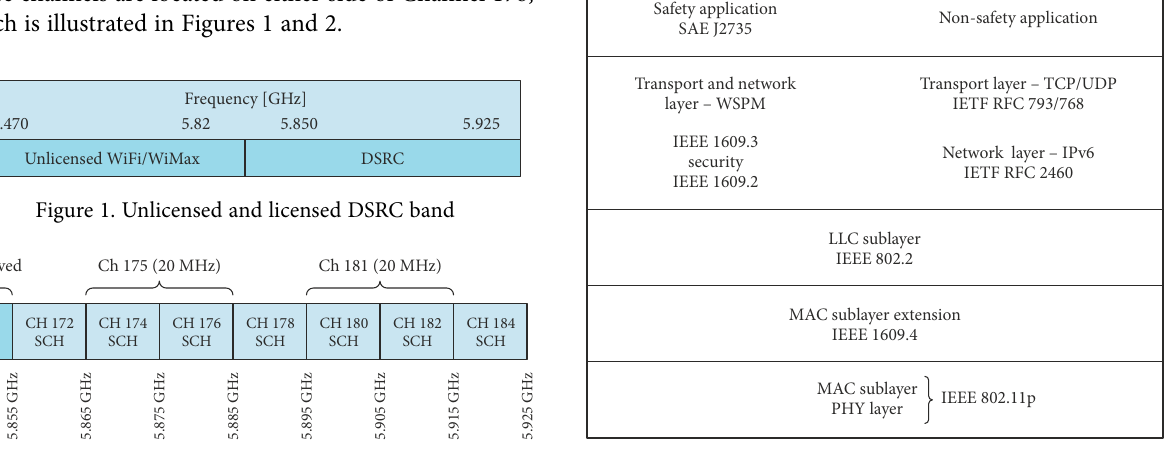
Figure 2. US DSRC band plan Figure 3. DSRC standard in the